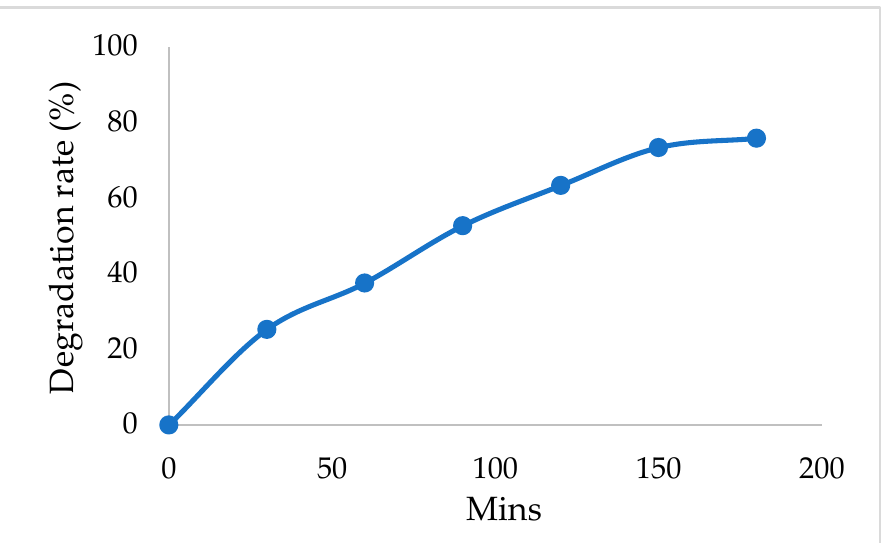
Figure 4. Preliminary test for CBZ degradation in the EC process with Pt/Ti electrodes (electrode distance: 1cm, potential: 3V).